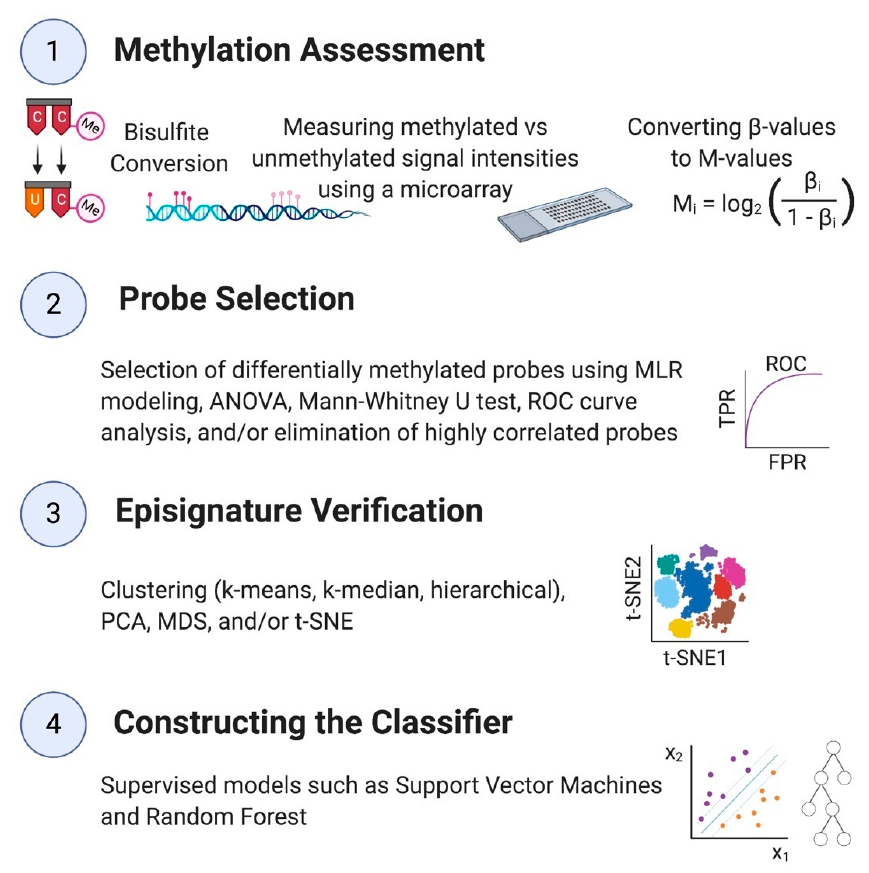
Figure 1. Summary of a DNA methylation analysis and constructing the classification model. Table 1. List of neurodevelopmental syndromes with a detected